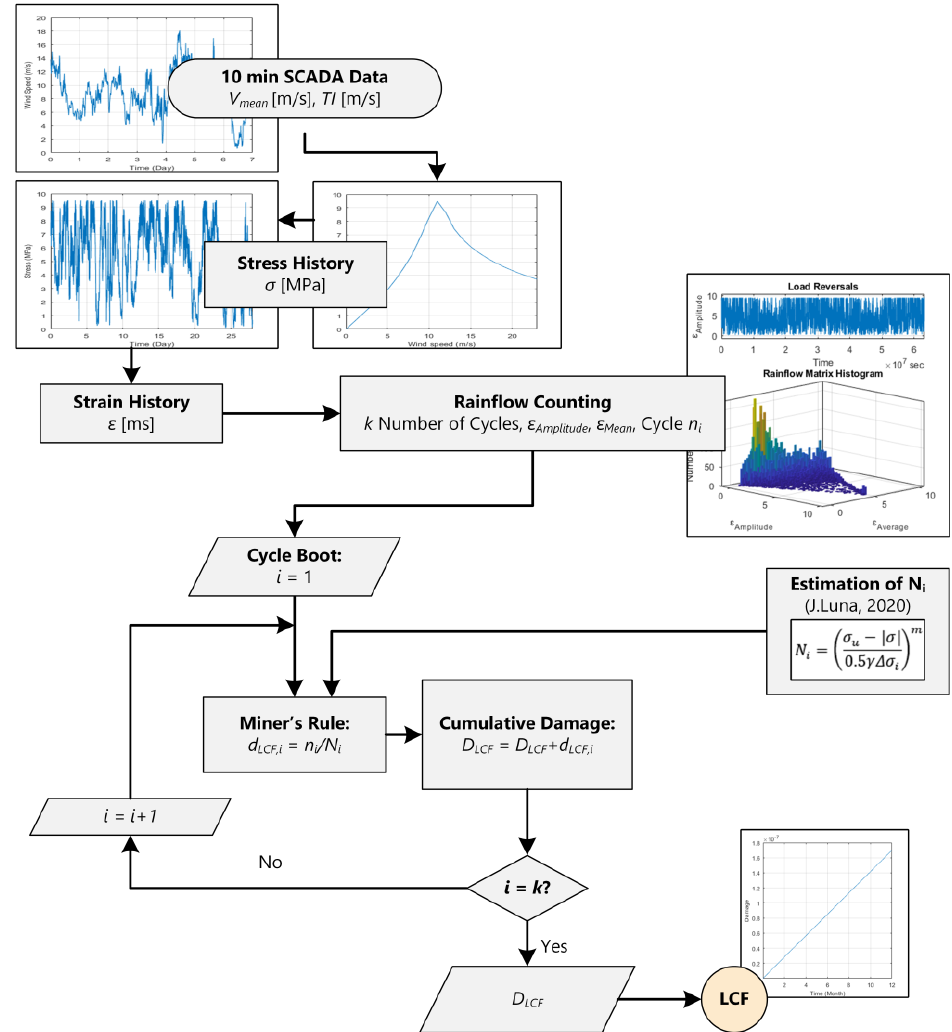
Figure 6. Flowchart showing the process leading to the estimation of the LCF damage from SCADA data.